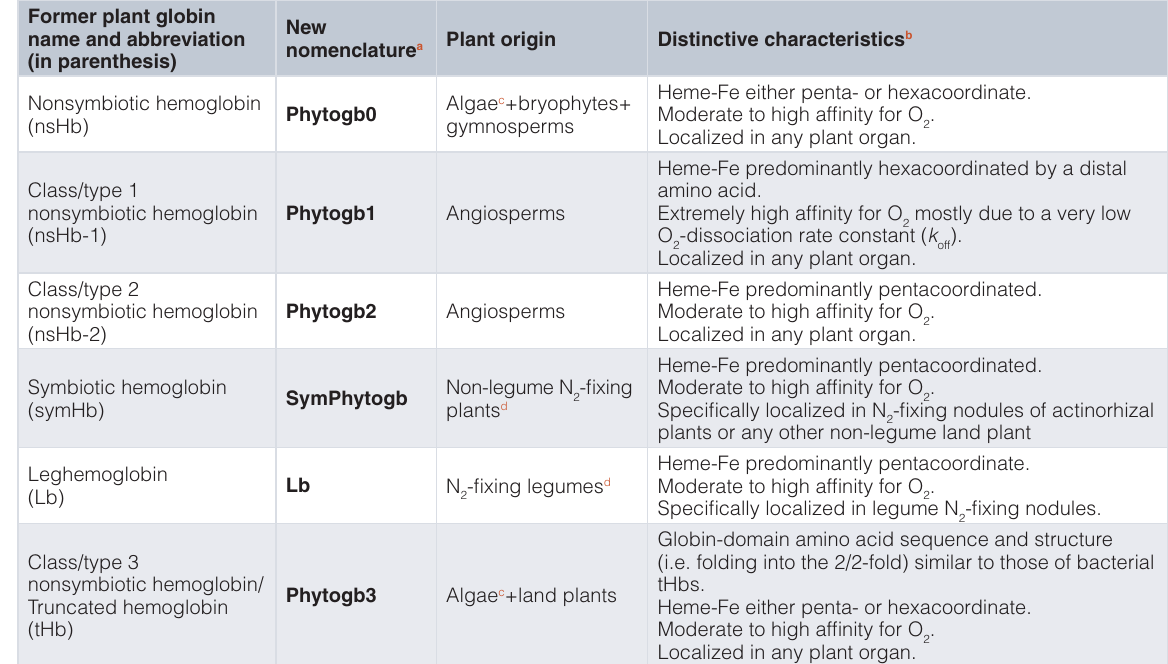
Table 1. System and characteristics of the accepted nomenclature for plant (algae + land plants) Phytoglobins